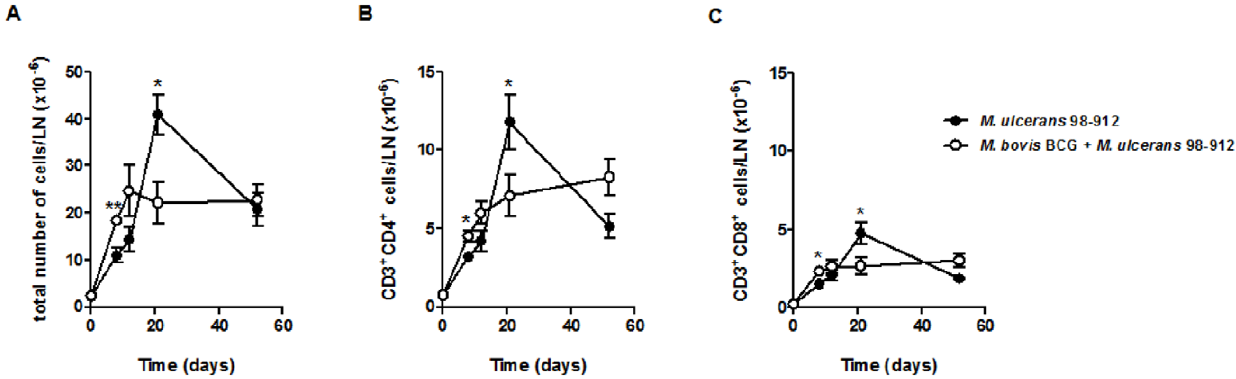
N Figure 3. Vaccination with BCG induces an early CD4 + T cell response in the DLN of M.ulcerans -infected mice. Mice were either non- ) or immunized with BCG ( # ) two months before challenge. All mice were infected in the footpad with 4 log 10 CFU of M. ulcerans 98– immunized ( 912. At different time points post-infection, the total number of leukocytes in the popliteal lymph node of the infected footpad was counted (A) and the number of CD4 + (B), and CD8 + (C) cells was determined by flow cytometry. The data points represent the mean 6 SEM ( n =5–8). Statistical significance was calculated with Student’s t test (* p , 0.05; ** p , 0.01). doi:10.1371/journal.pone.0033406.g003 PLoS ONE |